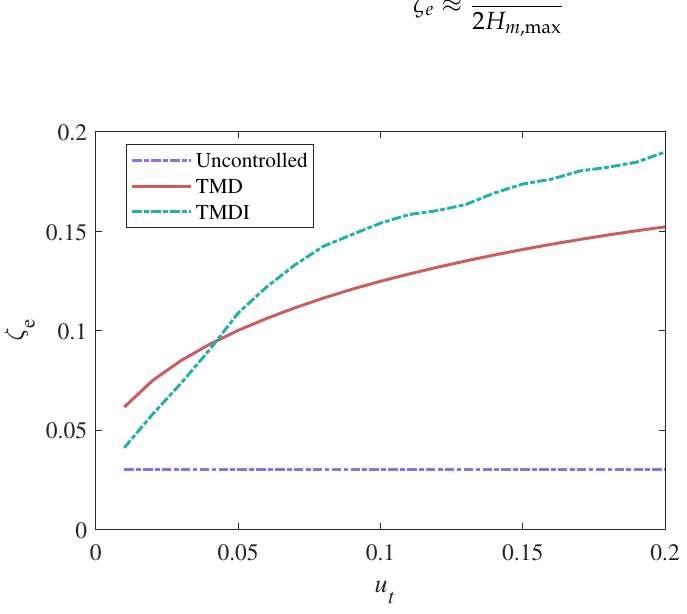
Figure 7. The equivalent damping ratio of the whole system varying with u t ( ζ s = 0.03).